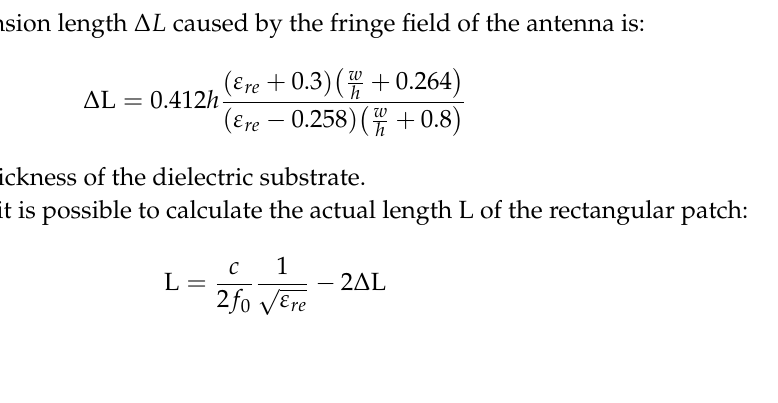
Figure 2. Geometrical configuration of the proposed antenna: ( a ) top view, ( b ) bottom view, and ( c ) side view.